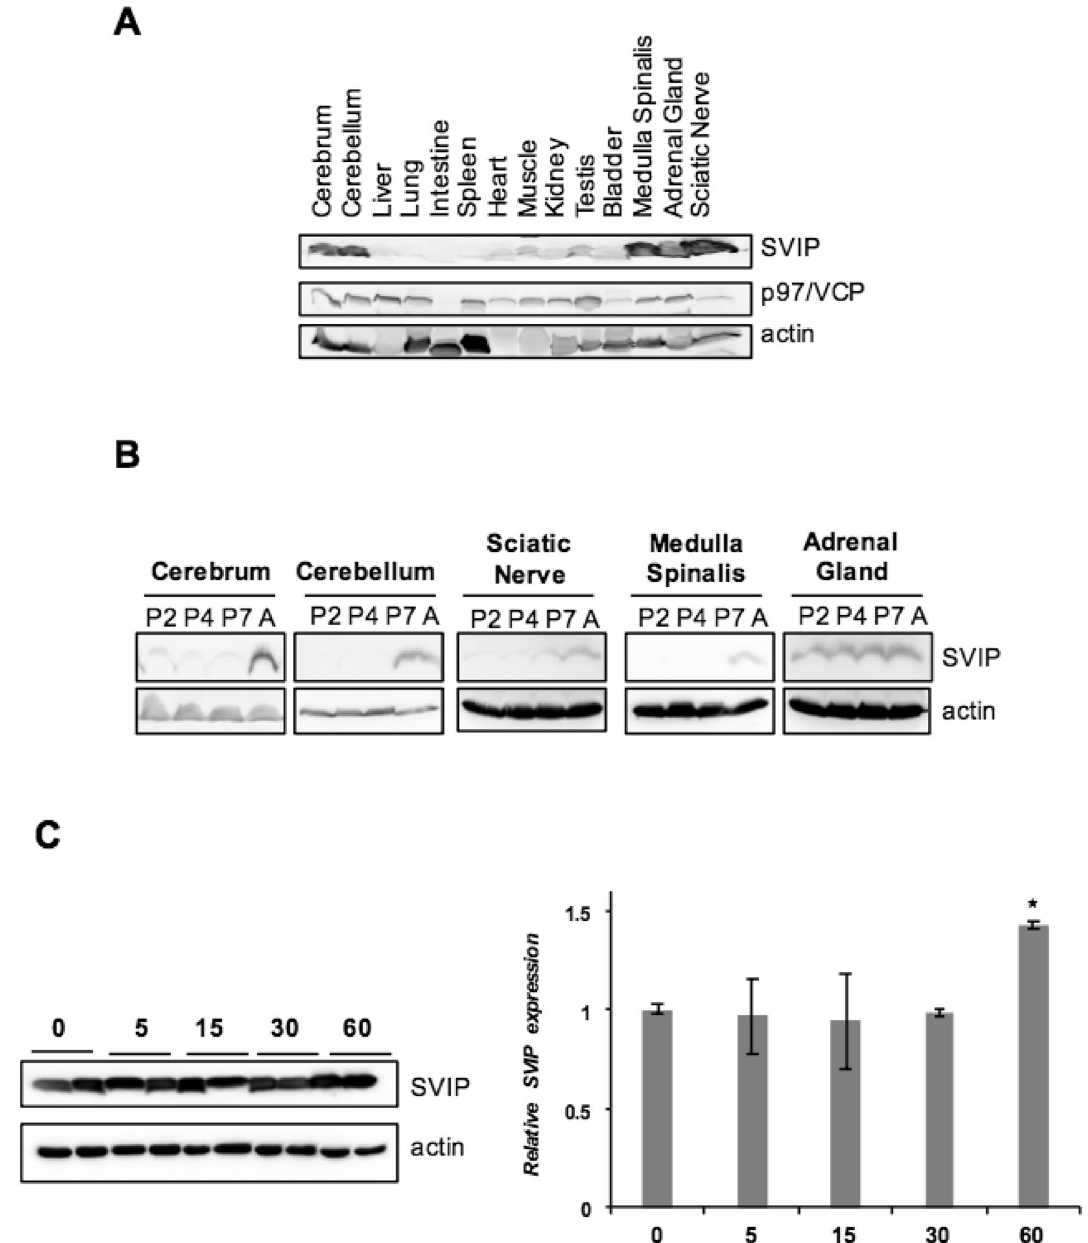
Figure 1. SVIP is highly expressed in adrenal gland. ( A ) Equal amounts of total protein from each organ extract were analyzed by immunoblotting (IB) with antibodies against SVIP and p97/VCP. ( B ) Mouse tissues were obtained at postnatal day 2, 4, 7, and 28 and processed for IB. ( C ) SVIP expression was investigated in the adrenal glands of rats at the indicated ages. The left shows representative Western blot images and the right shows the results of quantitative densitometric analysis of the changes in SVIP protein expression. Error bars indicate standard deviation (*p < H295R human adrenocortical cells were incubated with 10 µM forskolin or 0.5 mM 8-Br-cAMP for increasing time periods up to 24 h and evaluated SVIP expression by immunoblotting. Both treatments decreased the lev- els of SVIP protein while upregulating StAR (steroidogenic acute regulatory protein) (Fig. 5A,B), a protein that shuttles cholesterol from the outer to the inner mitochondrial membranes in a rate-limiting step 23 . H295R cells can also be differentiated into more “glomerulosa-like cells” and synthesize more aldosterone via pre-treatment with angiotensin II (Ang II) or potassium chloride (KCl) 24 . Our results showed that both KCl and Ang II also decreased SVIP protein levels similar to forskolin or 8Br-cAMP (Fig. 5C,D). In order to substantiate our findings and determine the mechanism underlying the downregulation of SVIP protein levels, we also evaluated the transcriptional regulation of SVIP by steroidogenic stimulators. Our data revealed that all tested stimulators diminished the SVIP mRNA compared to vehicle-treated control cells